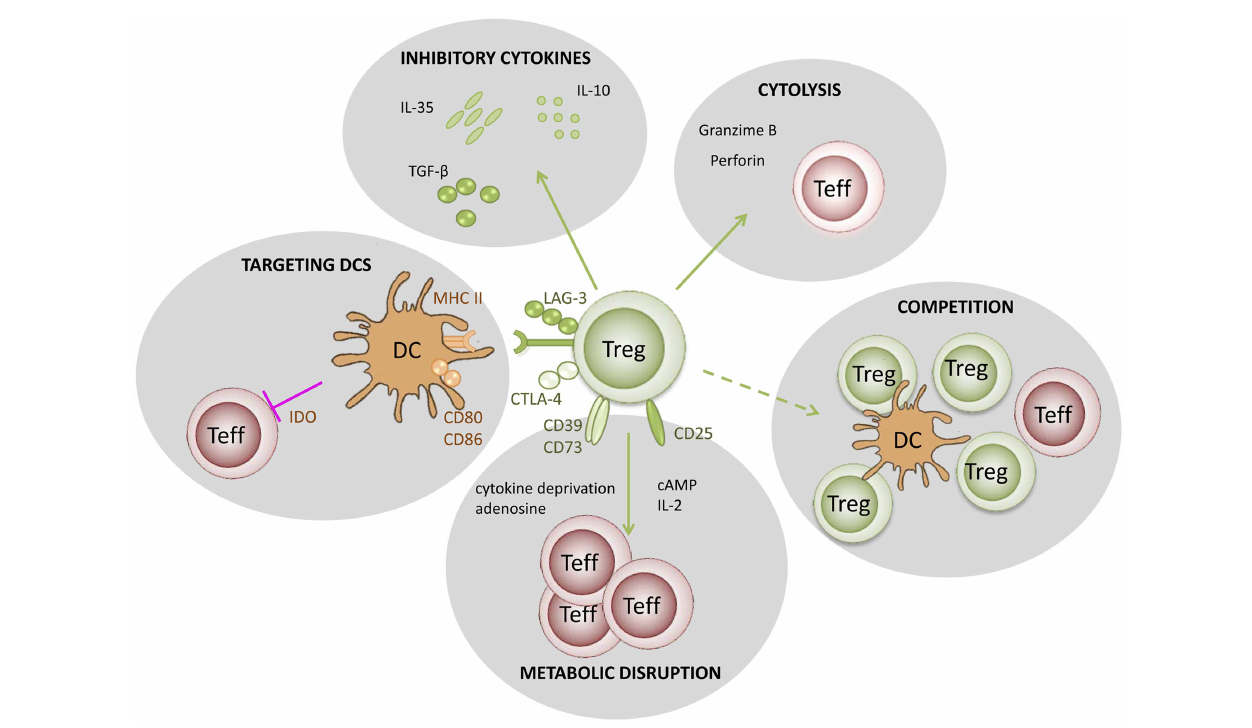
(A2A)-mediated immunosuppression; (3) Competition – for critical cytokines, such as IL-2, or direct disruption of effector cell engagement with APCs; (4) Cytolysis – direct cytotoxic effect through the production of Granzyme B and Perforin and consequent apoptosis of effectorT cells or APCs; (5) Production of inhibitory cytokines – including IL-10, IL-35, andTGF- β